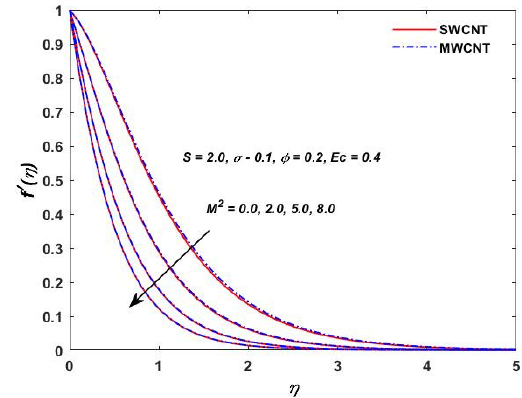
Figure 2. Magnetic parameter verses velocity 𝑓 (cid:4593) (𝜂).